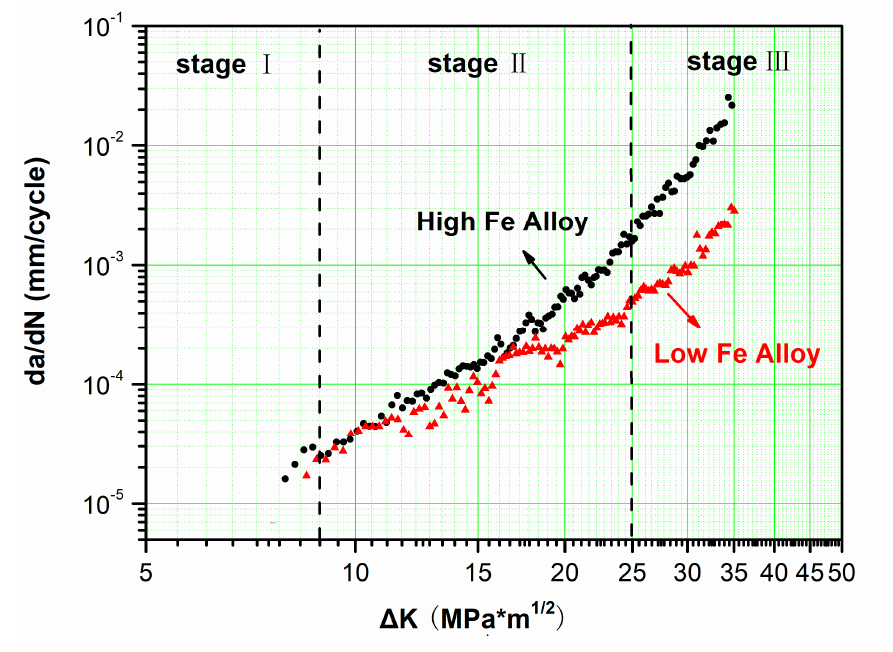
Figure 4. Fatigue crack growth rate versus Δ K curves for High Fe and Low Fe alloys.